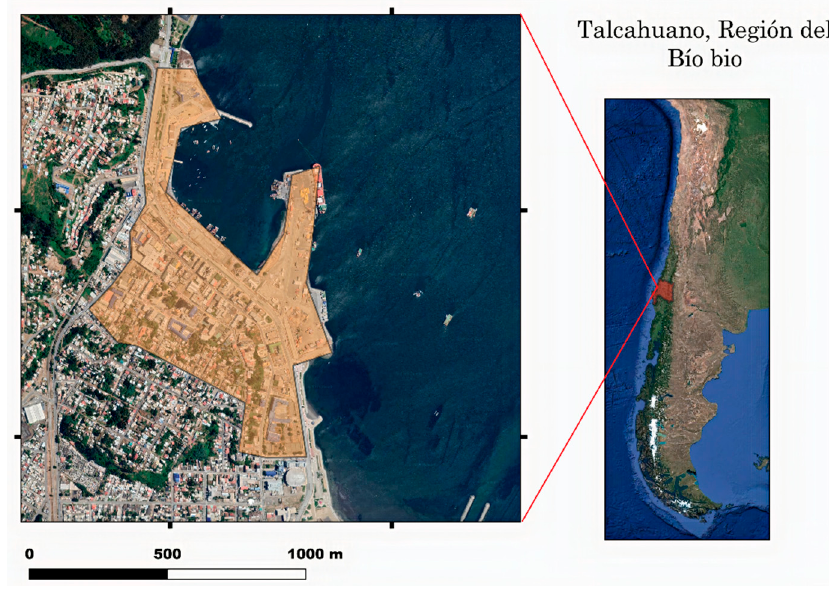
Figure 1. Study area: Talcahuano central area, Chile.